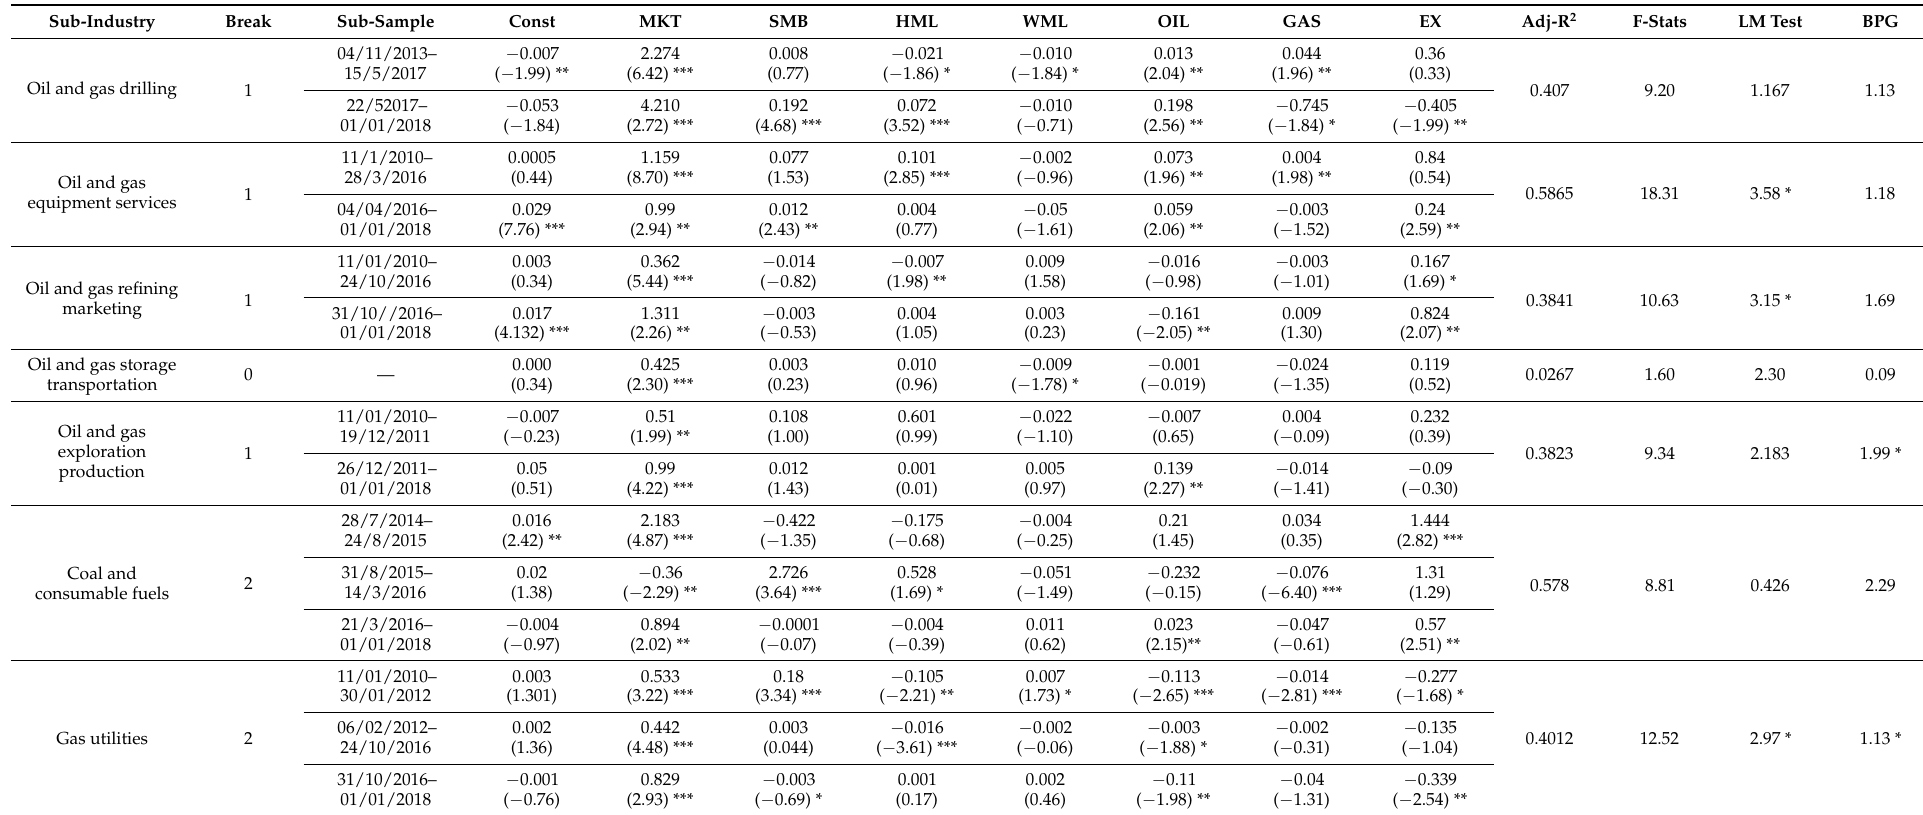
Table 4. Results of risk factors